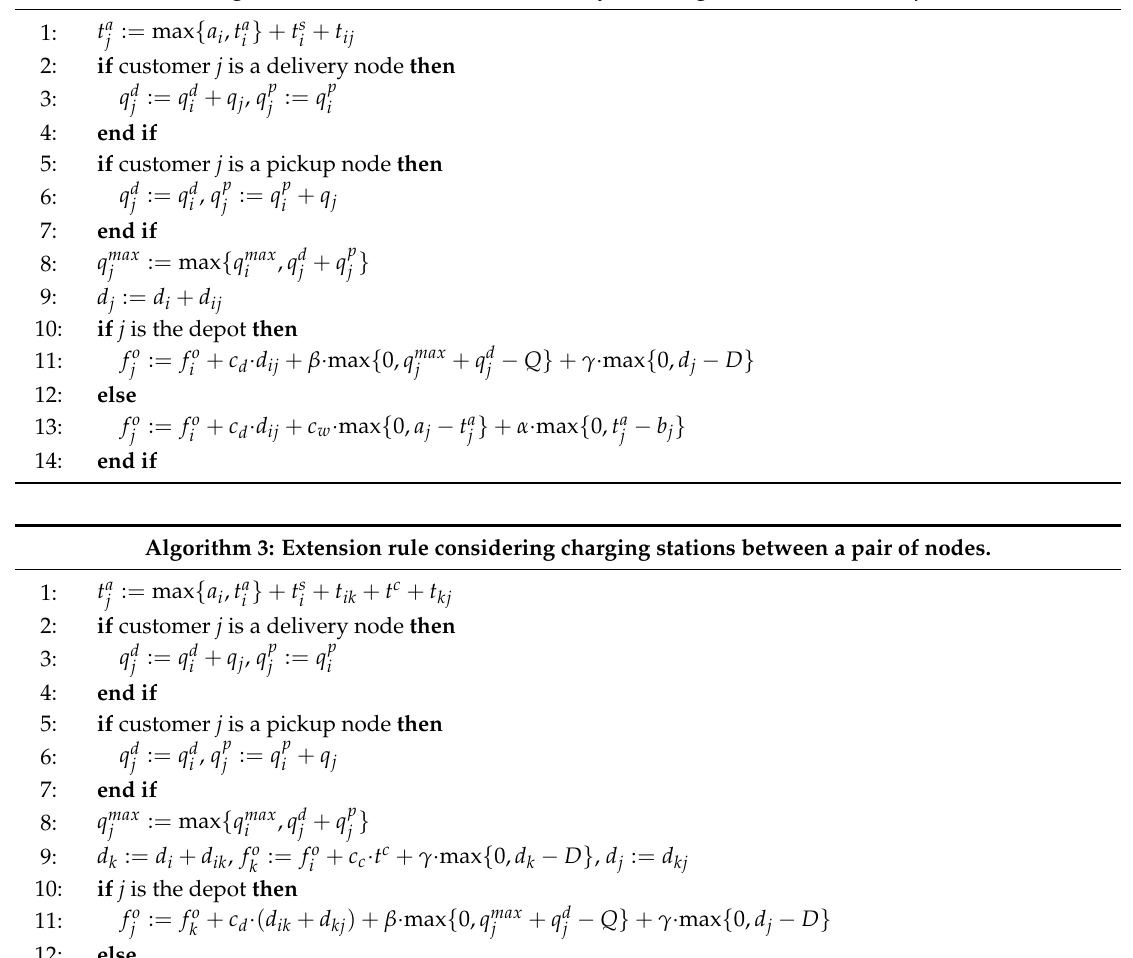
Algorithm 2: Extension rule for directly traveling from customers i to j.